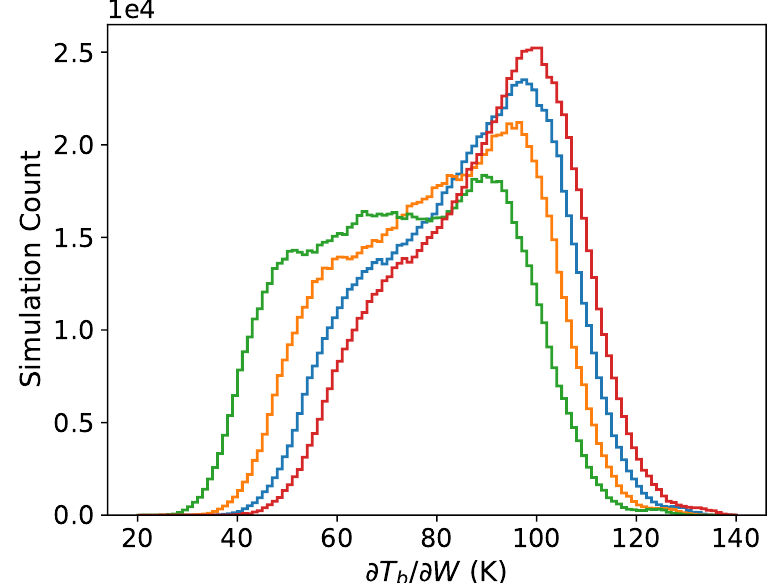
Figure 4. Distributions of ∂ T B / ∂ W at the surface (red) and at altitudes of 0.2 (blue), 0.5 (orange) and 1 km (green) for H polarization at 89 GHz and 53 ◦